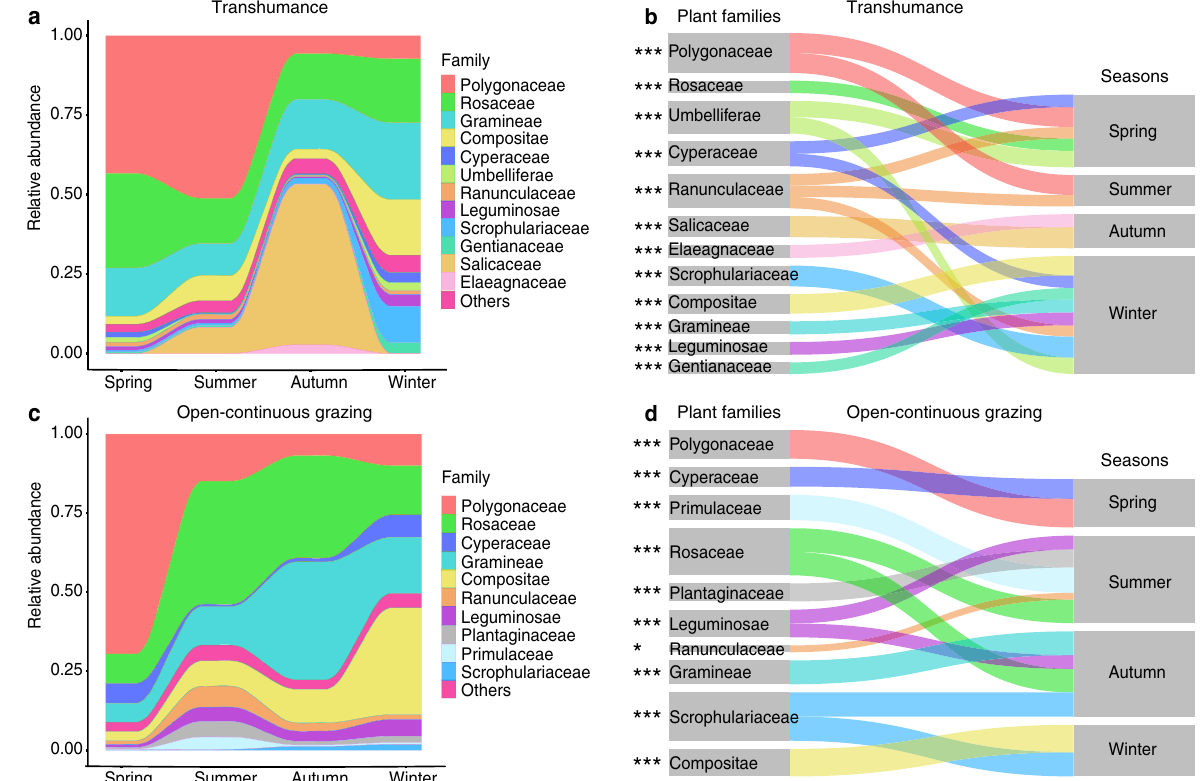
Fig. 2 Seasonal changes of dietary compositions of yaks in transhumance and open-continuous grazing regimes. Stream-graph displays the relative abundance of plant family-level taxa in spring, summer, autumn, and winter in transhumance ( a ) and open-continuous grazing ( c ) regimes. Low abundance taxa (<5%) are grouped together as “ others ” . Indicator families that are related to each season are tracked using Sankey plots in transhumance ( b ) and open-continuous grazing ( d ) regimes. Lines represent associations between indicator families and seasons, which are colored by plant family. Line width is scaled to re fl ect indicator value (higher indicator value of family is more strongly associated with season). Indicator values are presented in Supplementary Fig. 7. The statistical p values mean the family associated with seasons, * p < 0.05, ** p < 0.01, *** p <